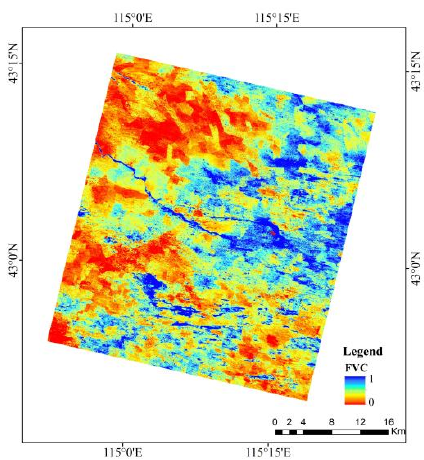
Figure 4. Distribution of vegetation coverage.